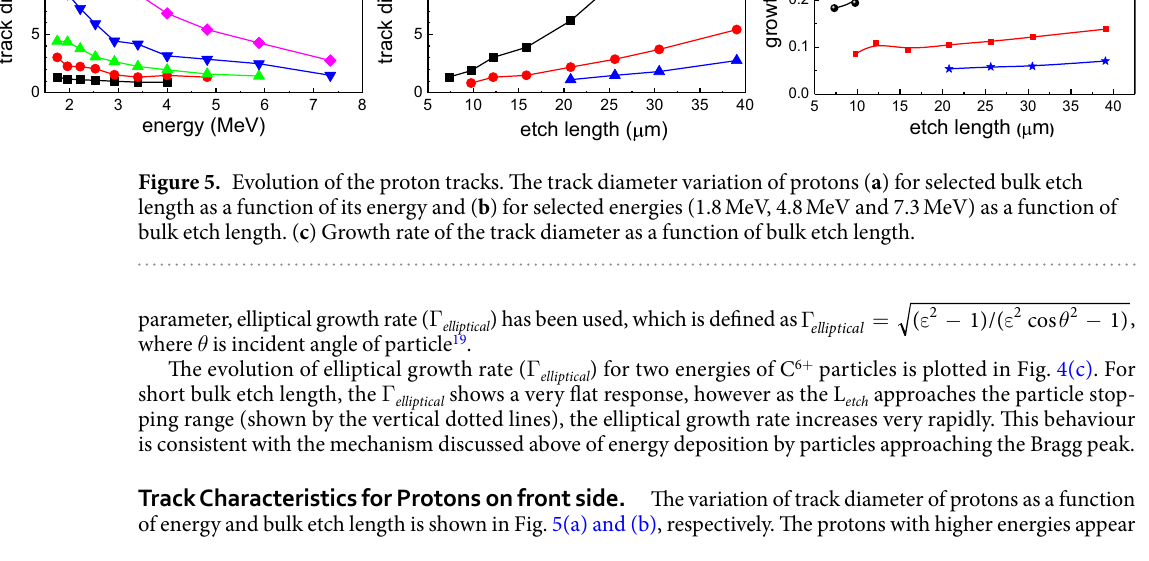
where θ is incident angle of particle 19 .